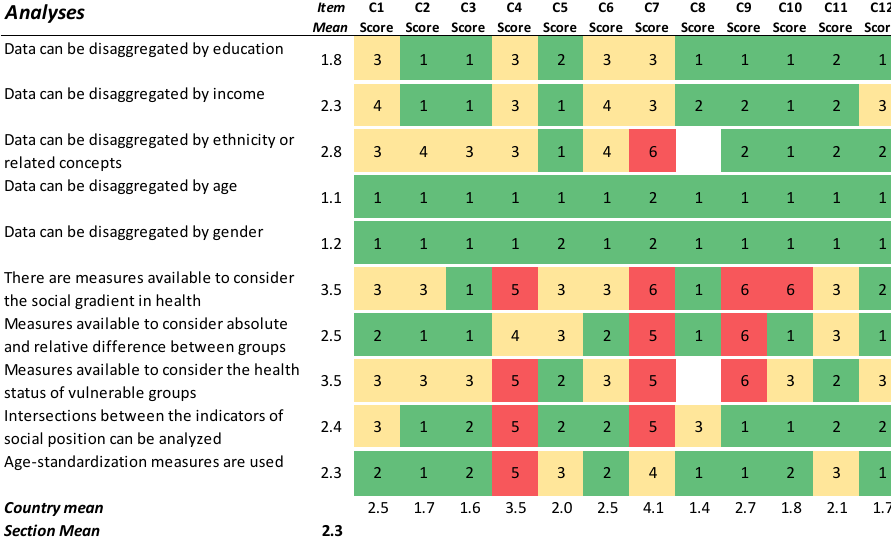
Figure 3. Results for the section ‘Analyses’. Green cells (scores 1–2) indicate agreement with the statement. Yellow cells (scores 3–4) indicate partial agreement/disagreement, and red cells (scores 5–6) indicate the most challenging preconditions for an ideal HIMS.